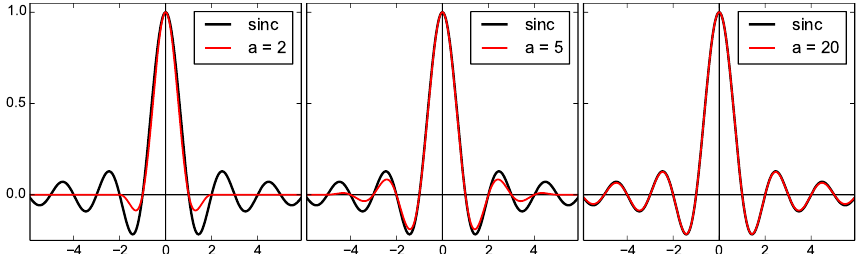
Figure 8. Lanczos kernels used for resampling. For large values of the parameter a , it converges towards the sinc function, which is the kernel that allows exact reconstruction for bandlimited signals as stated in the Nyquist sampling theorem (Nyquist, 1928).